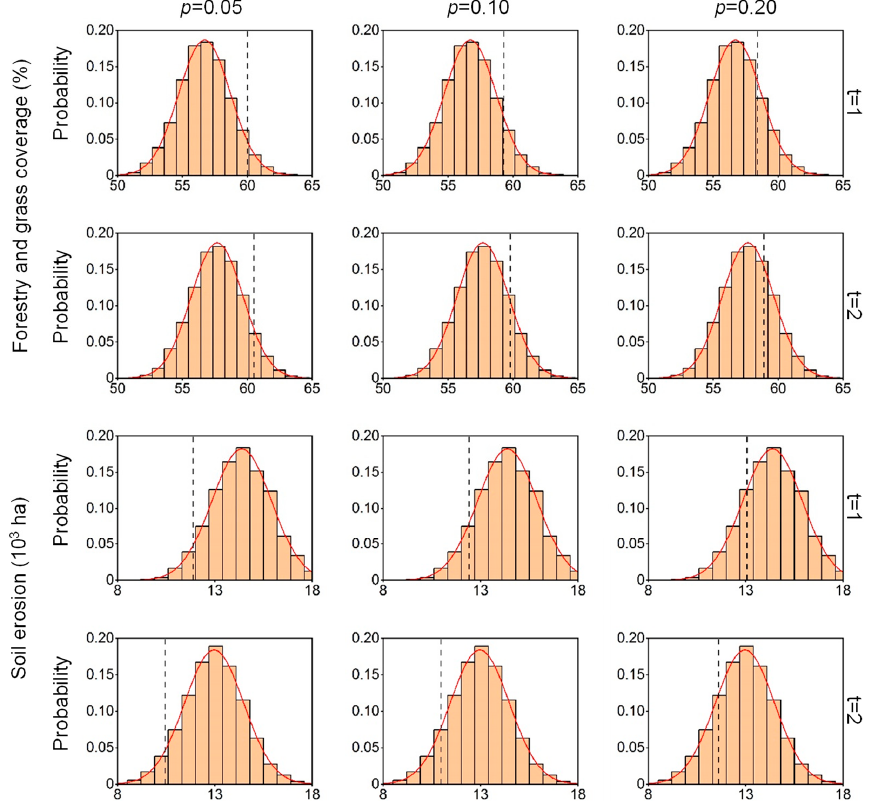
Figure 2. Probability distributions of forestry and grass coverage and soil erosion. Table 3. Results of Monte Carlo simulation.